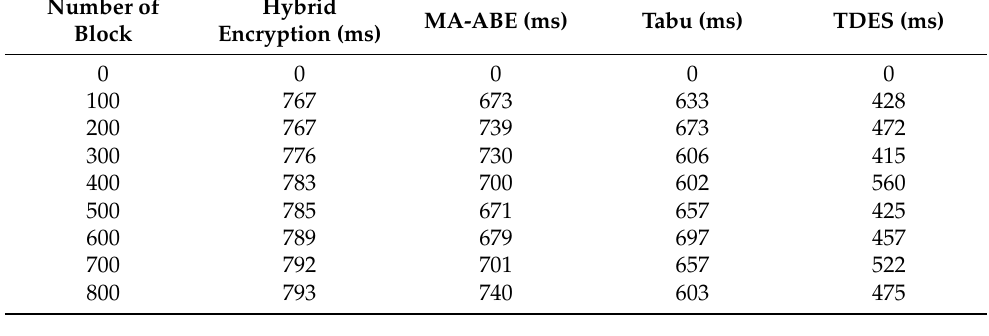
Table 8. Decryption time of TDES and comparison with existing methodologies.